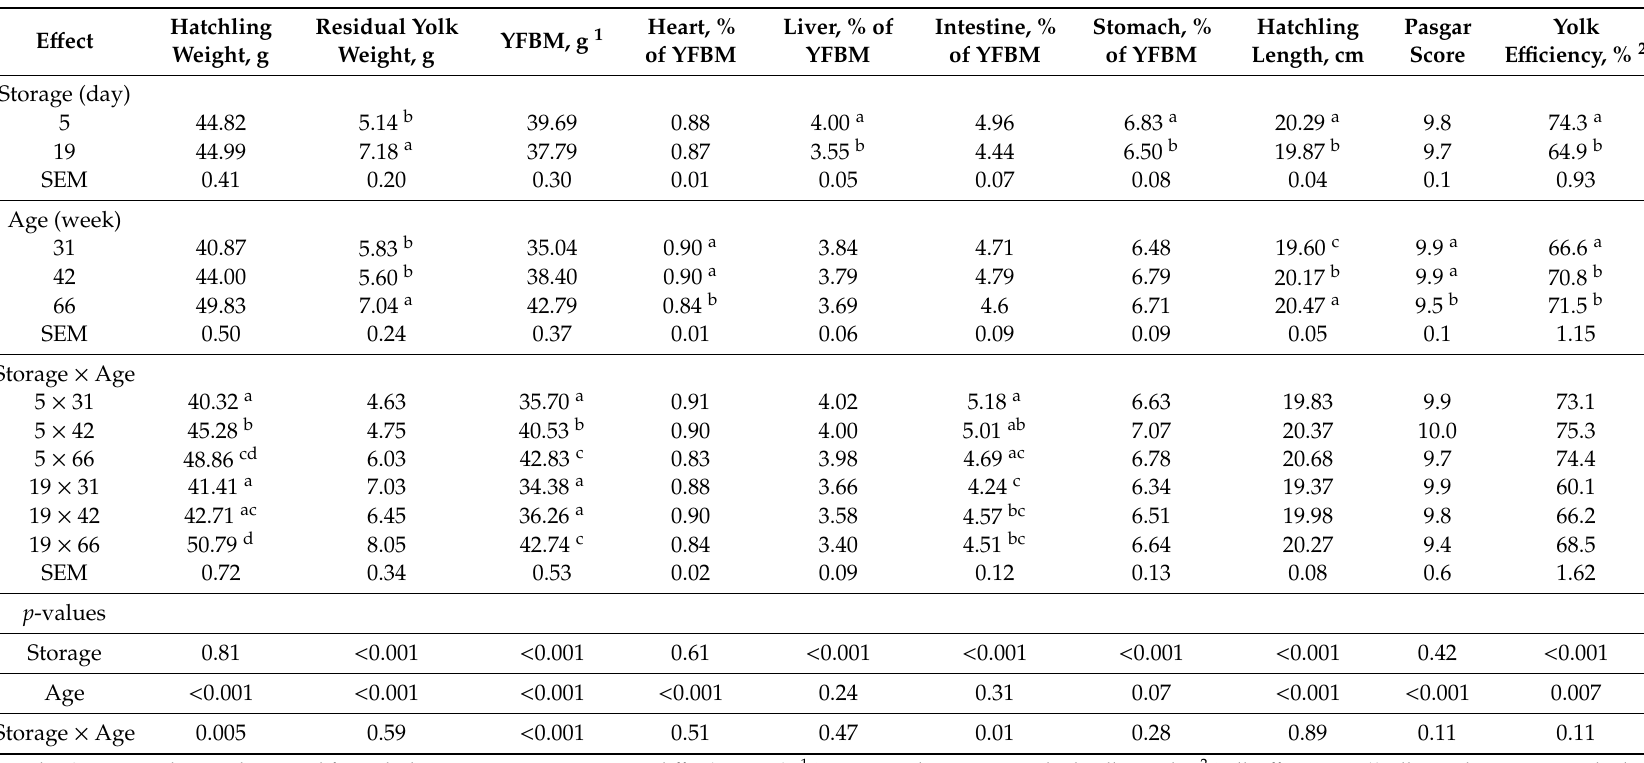
Table 4. E ff ects of egg storage duration, broiler breeder age and their interaction on chicken quality characteristics and organs weight at hatching (LSmeans ± SEM). Hatchling E ff ect